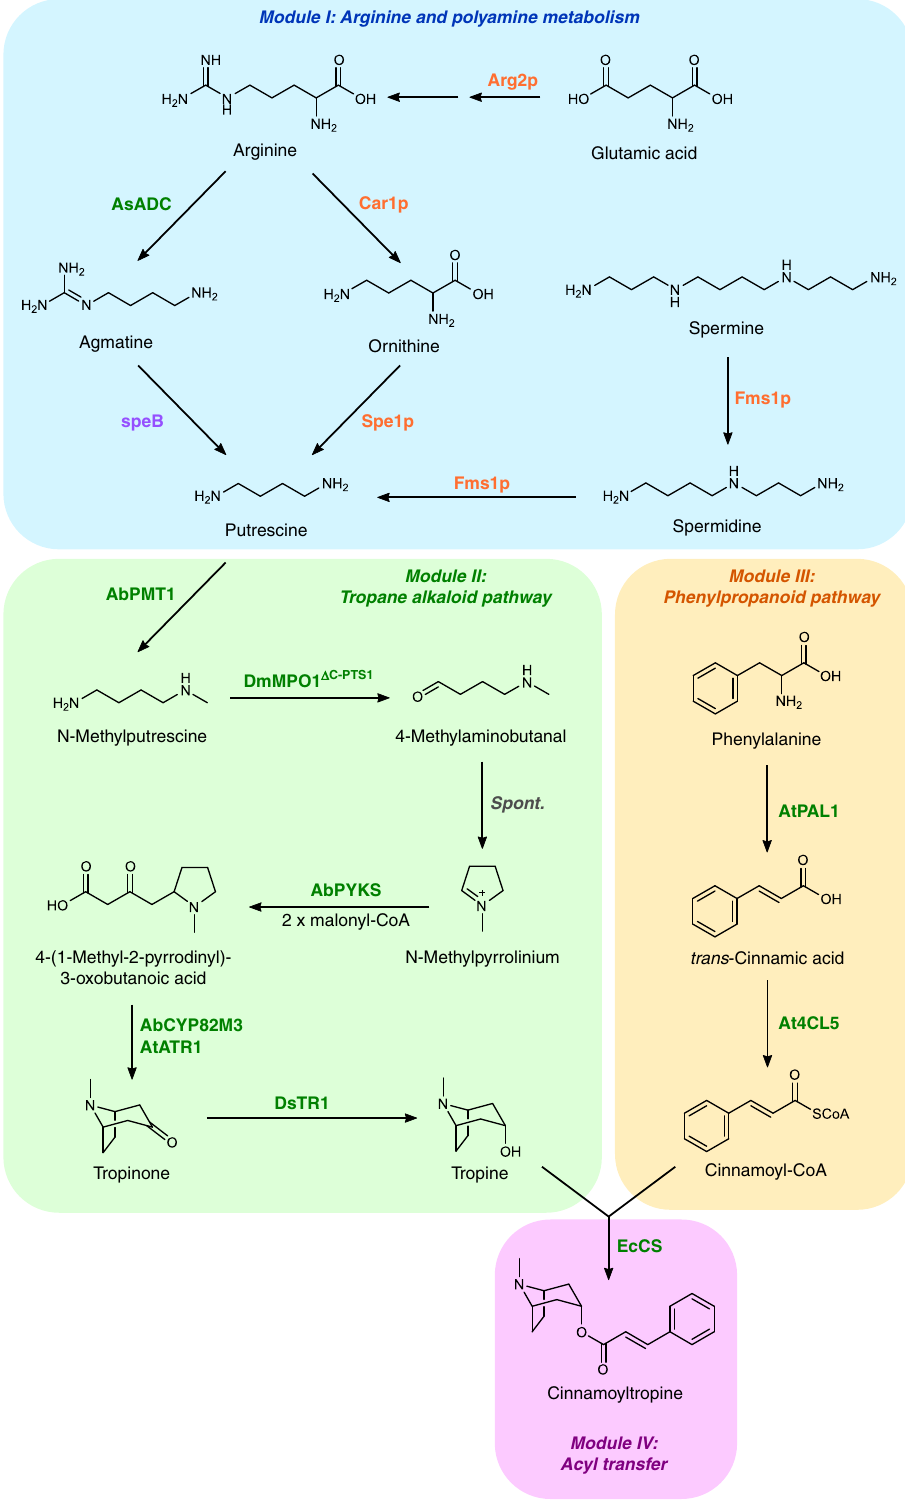
Fig. 1 Engineered pathway for de novo biosynthesis of tropane alkaloids in yeast. Color scheme for enzyme labels: orange, overexpressed yeast enzymes; green, plant enzymes; violet, bacterial enzymes; grey, spontaneous (non-enzymatic) step. Enzyme symbols: Arg2p, glutamate N- acetyltransferase; Car1p, arginase; AsADC, Avena sativa arginine decarboxylase; speB, agmatine ureohydrolase; Spe1p, ornithine decarboxylase; Fms1p, polyamine oxidase; AbPMT1, Atropa belladonna putrescine N- methyltransferase 1; DmMPO1 Δ C-PTS1 , Datura metel N- methylputrescine oxidase 1 with peroxisome targeting sequence 1 and truncated C-terminus; AbPYKS, A. belladonna pyrrolidine ketide synthase; AbCYP82M3, A. belladonna tropinone synthase; AtATR1, Arabidopsis thaliana NADP + -cytochrome P450 reductase; DsTR1, Datura stramonium tropinone reductase I; AtPAL1, A. thaliana phenylalanine ammonia-lyase; At4CL5, A. thaliana 4-coumarate-CoA ligase 5; EcCS, Erythroxylum coca cocaine synthase